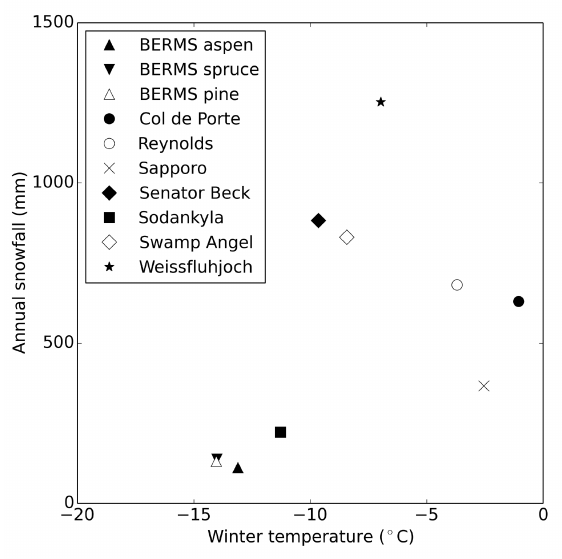
Figure 1. Winter (DJF) temperatures and annual snowfall averaged over the forcing data periods at the ESM-SnowMIP reference sites (see Table